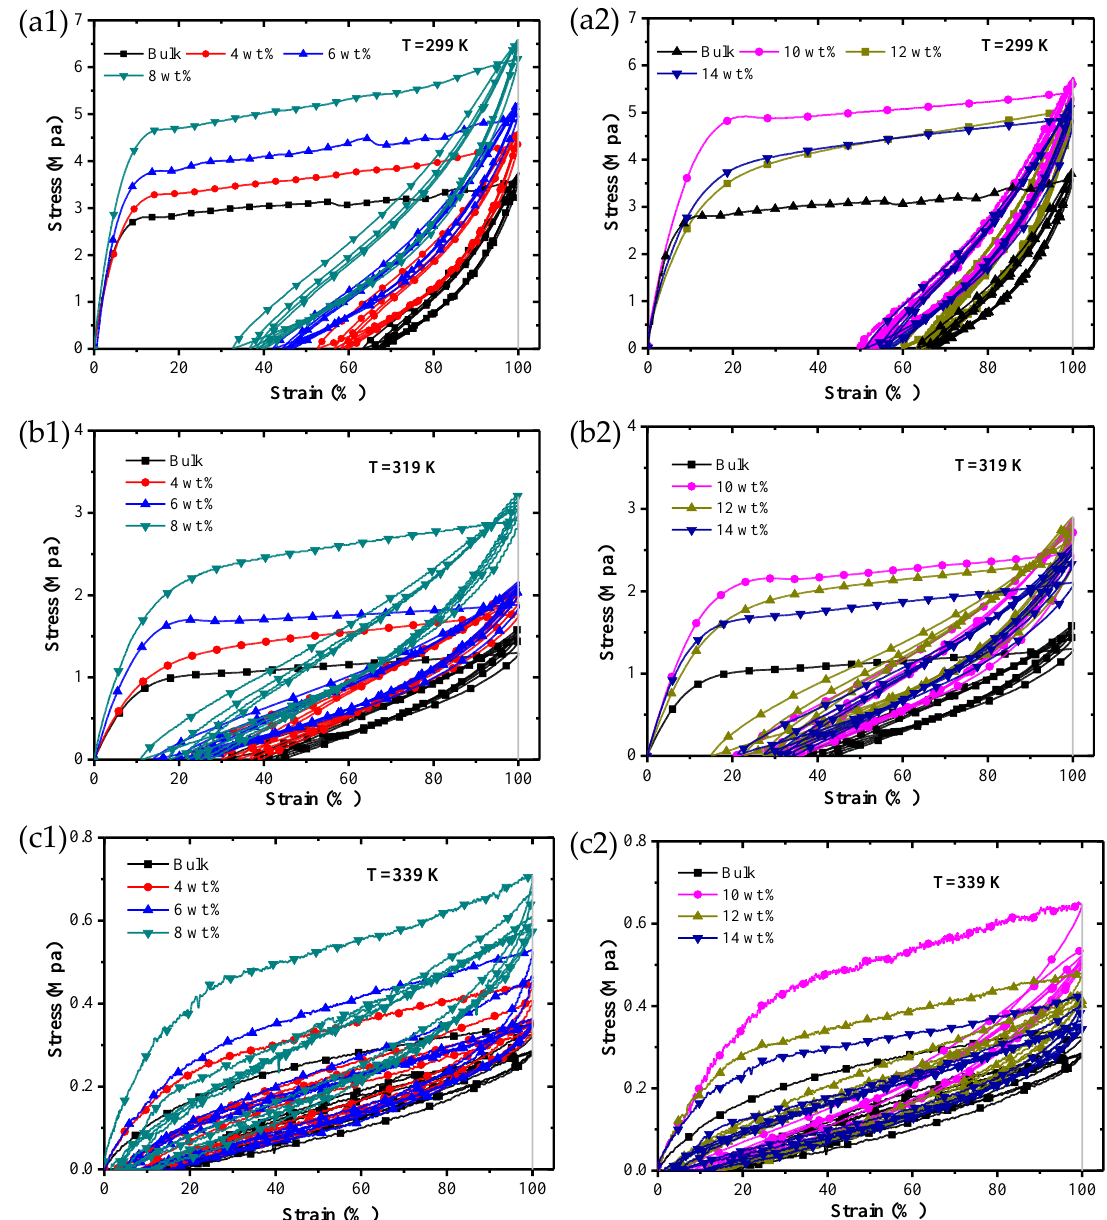
Figure 14. The stress–strain curves of SMP composite specimens with different chopped carbon fiber mass fractions under a constant-strain cyclic loading at three test temperatures: ( a1 , a2 ) 299 K; ( b1 , b2 ) 319 K; ( c1 , c2 ) 339 K.